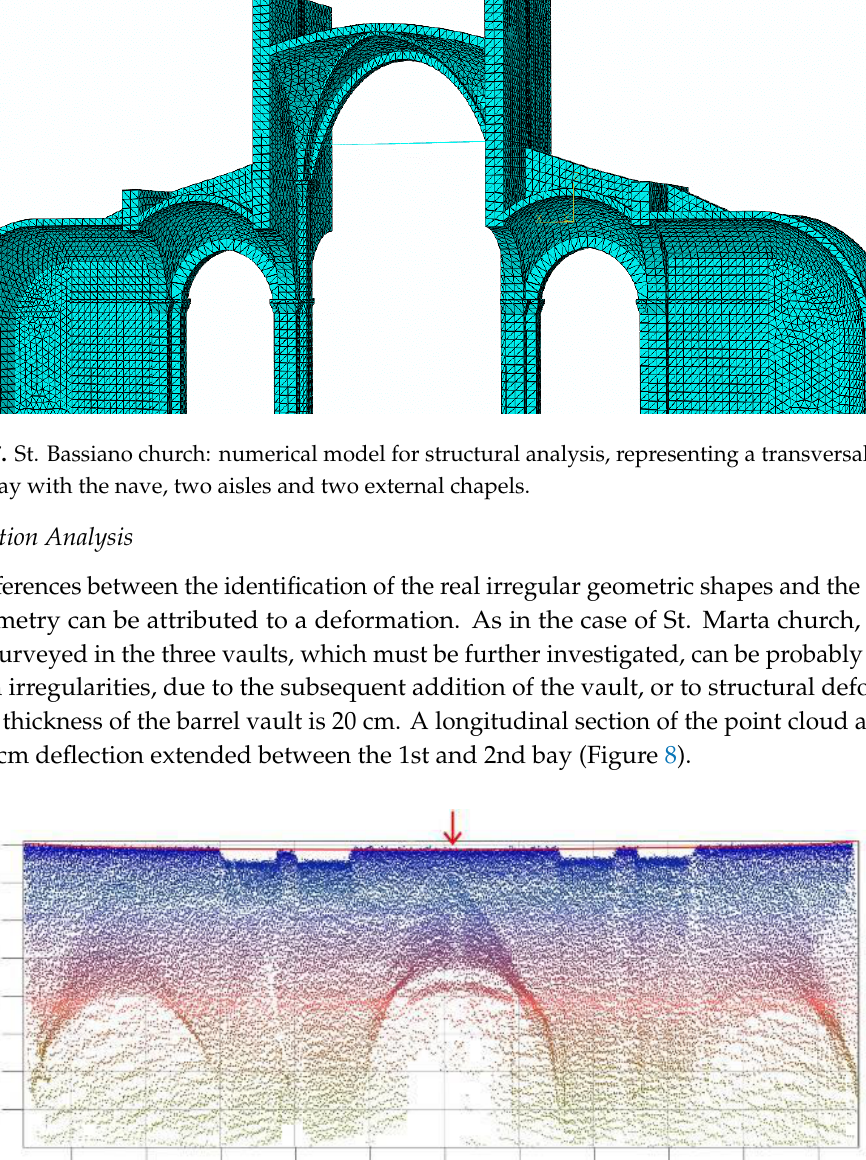
Figure 8. Side view of the point cloud with deformation indication.